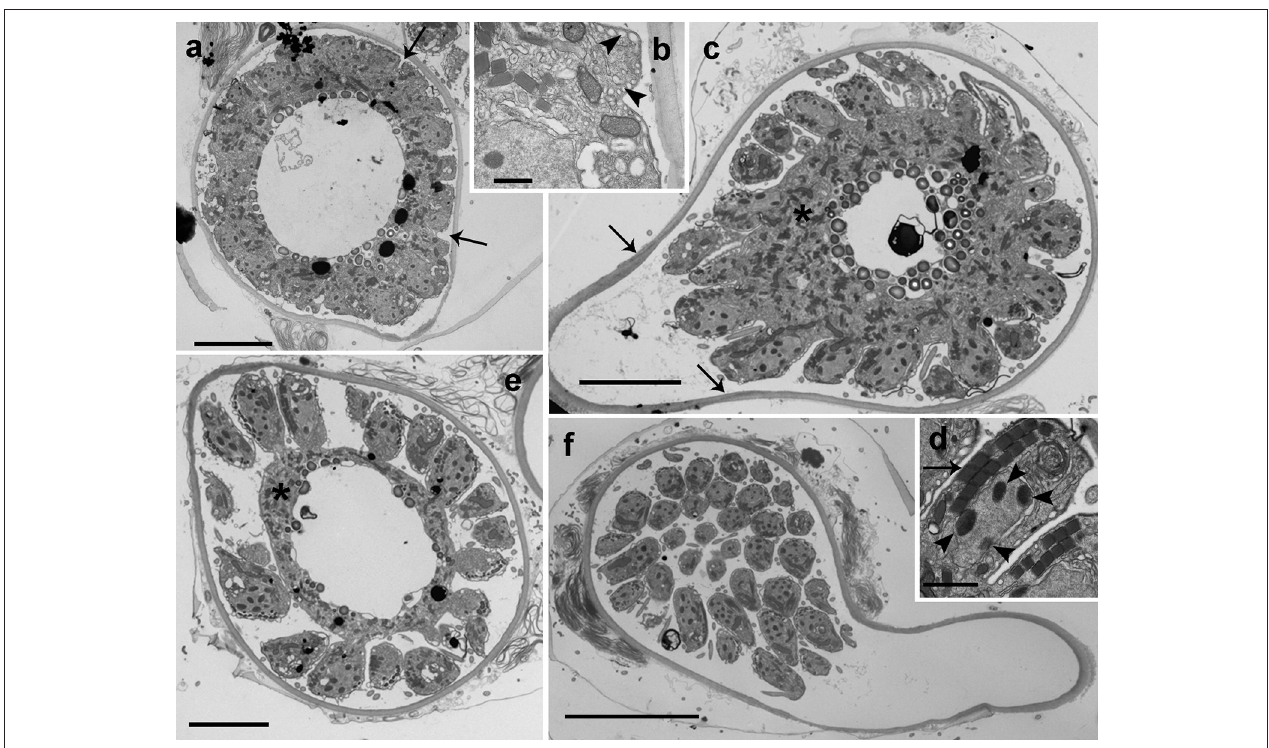
FIGURE 4 | Transmission electron microscopy micrographs showing the life-cycle stages from late sporocyte to sporangium of Dinovorax pyriformis infecting Prorocentrum micans . (a) Late sporocyte with invaginations at the periphery that correspond to initial stage of zoospore cytokinesis (arrows). (b) Detail of the invaginations. Alveoli can be observed at a subcortical position (arrowheads). (c) Sporocyte with zoospores in formation from the central undifferentiated cytoplasm (asterisk). The arrows indicate the suture among the sporangium and the germ-tube walls. (d) Detail of an immature zoospore already showing the characteristic heterochromatin bodies in the nucleus (arrowheads) and two rows of trichocysts (arrow). (e) Late sporocyte with zoospores almost formed. The undifferentiated cytoplasm (asterisk) of the sporocyte is gradually consumed. (f) Sporangium in longitudinal section containing many mature zoospores detached from the central body. All scale bars = 5 µ m, except (b) = 500nm, (d) = 1 µ m and (f) = 10 µ